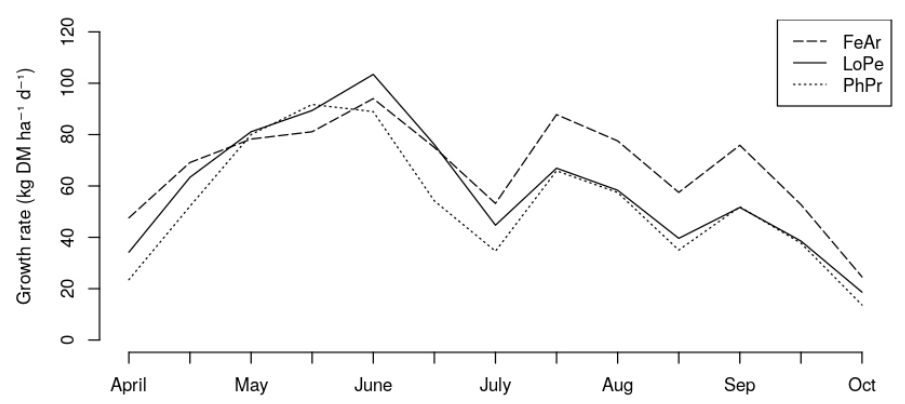
Figure 1. Grazing regime: Growth rates (kg DM ha − 1 d − 1 ) of FeAr: Festuca arundinacea, LoPe: Lolium perenne ,